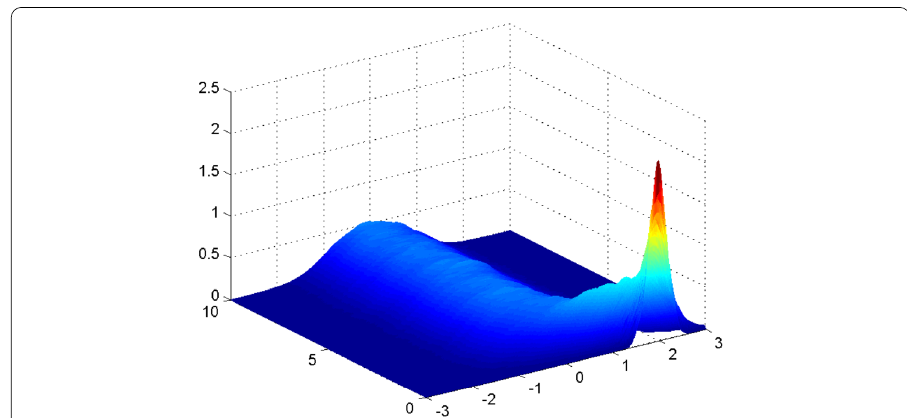
Figure 3 Empirical probability density functions after switching